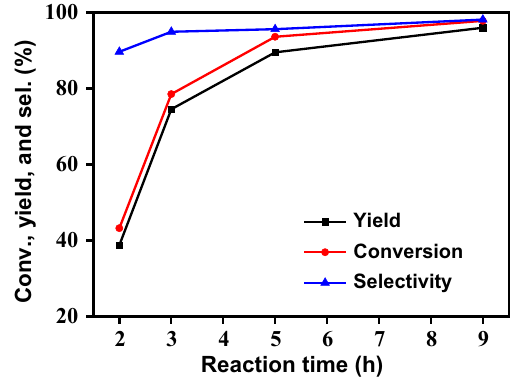
Fig. 4 Influence of the reaction time. Reaction conditions: furfural 1 mmol, isopropanol 5 mL, Zr-TMSA (1:3:0.75) 200 mg, reaction temperature 70 (cid:3)